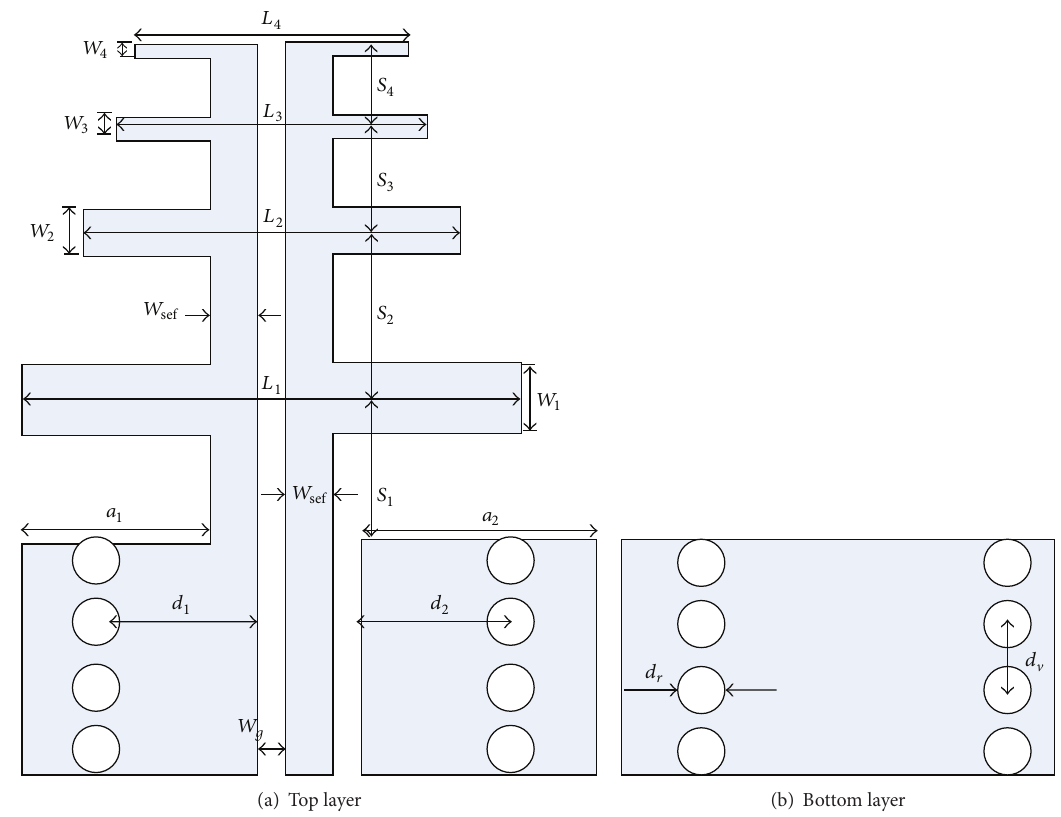
Figure 1: Geometry of the proposed CBCPW PLPDA antenna.